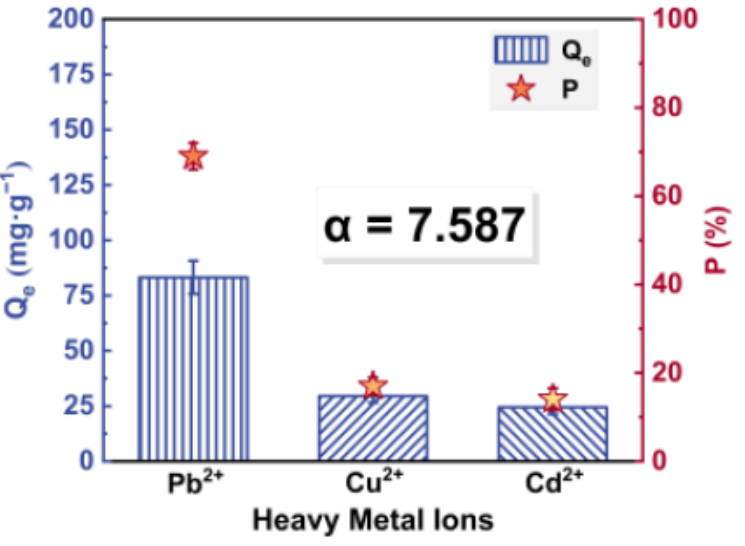
Figure 6. The partition coefficients and selective removal coefficient of the composite hydrogel. The selective removal coefficient for CTS/CA/BT composite hydrogel was